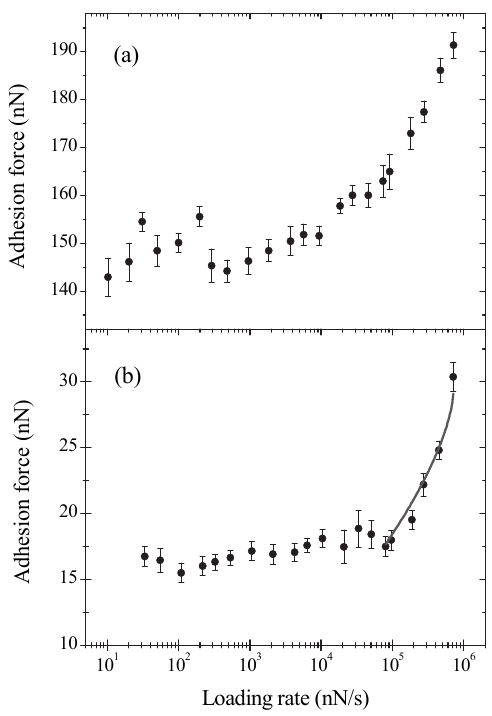
Fig. 6 Adhesion force-versus-loading rate plotted at a logarithmic scale for the interaction between a silicon nitride AFM tip and monolayers of 11-mercapto-1-undecanol (a) and 1-dodecane- thiol (b) at a relative humidity of 20%. The solid line (b) represents a fit of the DHS model to ex- perimental data at high loading rates (>7 × 10 4 nN/s). For details see ref. 59)